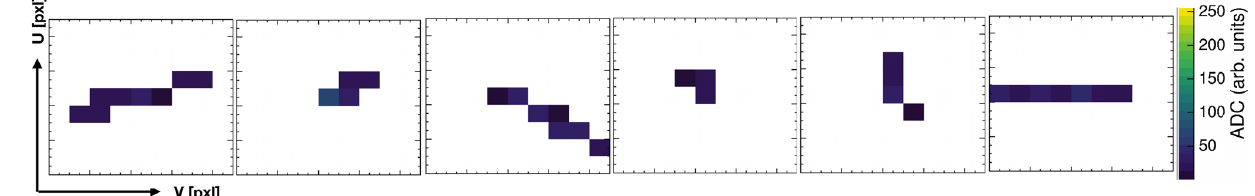
Fig. 1 Example clusters of single-beam background particles from the inner region of the PXD (pixel dimensions: 50 µ m × 55 µ m ). The seed pixel is located at the centre of the 9 × 9 pixel matrix. The colour scale represents the single-pixel charge in ADC values